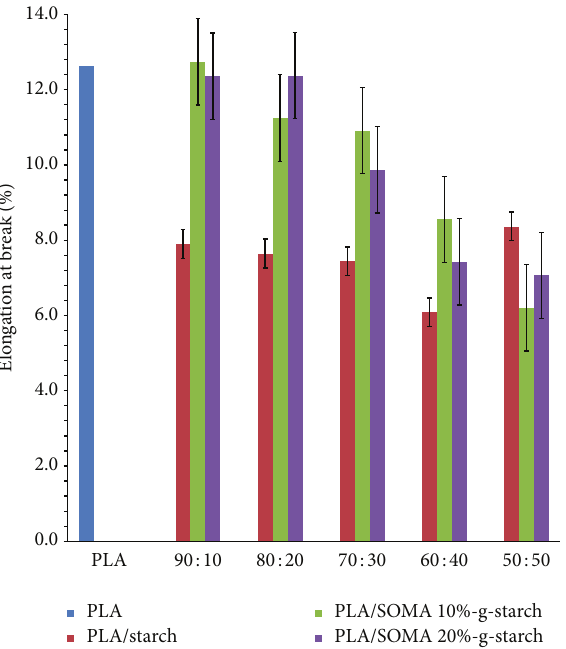
Figure 8: Tensile strength values of PLA, PLA/Starch composites, and PLA/SOMA-g-STARCH composites. Figure 9: Percent elongation at break values of PLA, PLA/Starch composites, and PLA/SOMA-g-STARCH